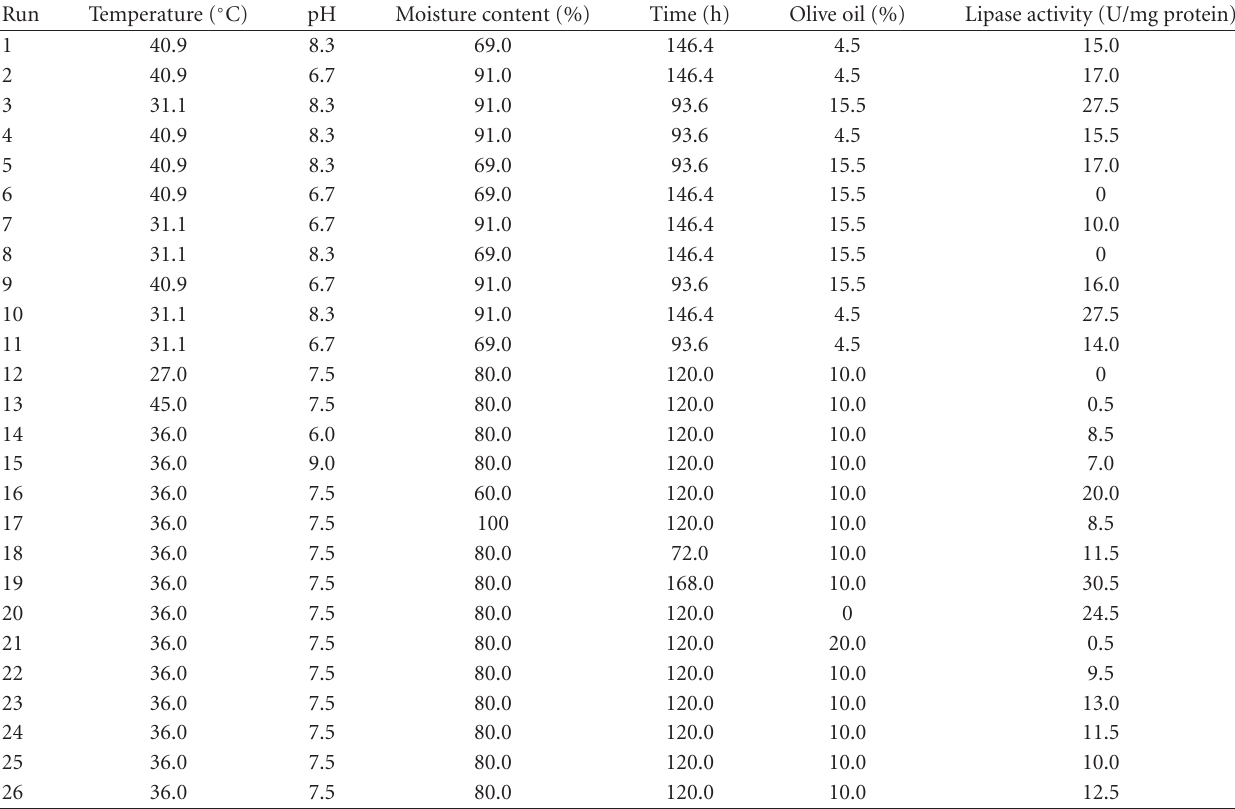
Table 2: Experimental design used in ANN studies by using five independent variables showing observed values of lipase activity in